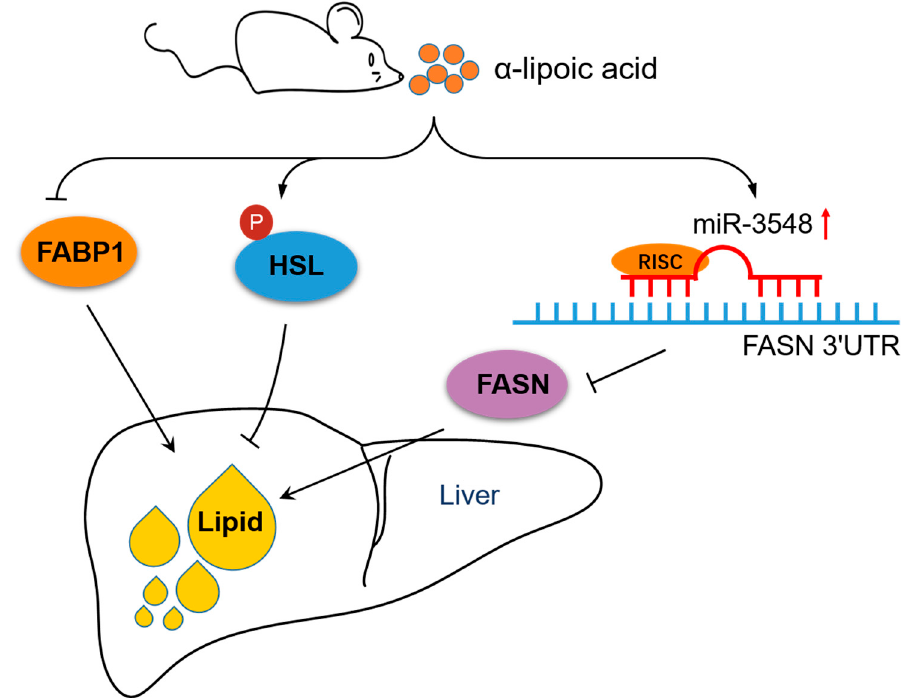
Figure 6. Schematic diagram of the mechanisms of α -lipoic acid related to reduced hepatic lipid accumulation. α -Lipoic acid suppresses FASN and FABP1 expression and enhances p-HSL expression, resulting in reduced hepatic lipid deposition. Impaired FASN expression is mediated by miR-3548 in the liver of α -lipoic acid-fed rats. FABP1: Fatty acid-binding protein 1, HSL: Hormone-sensitive lipase, FASN: Fatty acid synthase, RISC: RNA-induced silencing complex. Supplementary Materials: The following are available online at www.mdpi.com/xxx/s1, Table S1: Nucleotide sequences of specific primers, Table S2: Details of antibodies used in the experiment, Table S3: miRNA and the corresponding primer sequences, Figure S1: Volcano plot depicting differential expression of hepatic miRNAs in rats fed on α -lipoic acid.